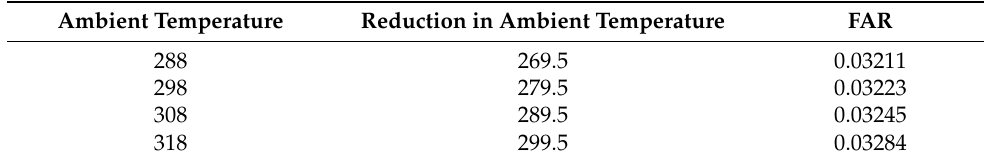
Table 4. Effects of the ELNG cycle on the fuel-to-air ratio and the ambient temperature. Ambient